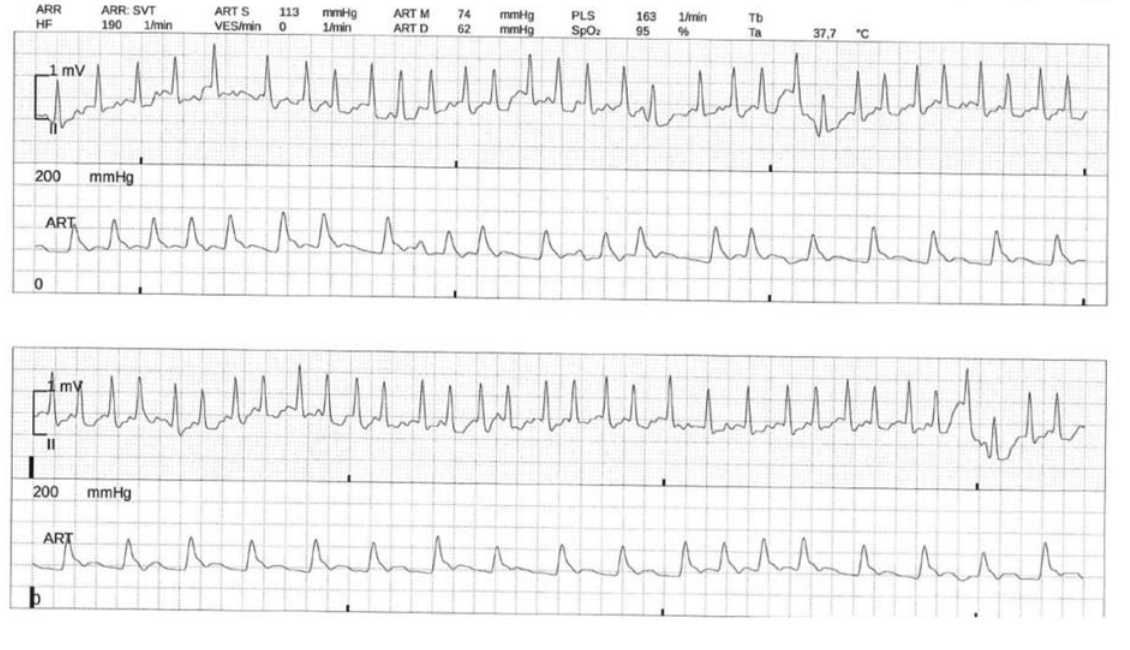
Fig. 2 Atrial fi brillation with tachycardic conduction to the ventricles (electrocardiograms both upper rows) as a possible sign for atrial cardiomyopathy. Peripheral pulse de fi cit as depicted in the arterial pressure measurement due to an increased heart rate of around 190 beats per minute (bpm) with a peripheral pulse de fi cit (163 bpm; both lower